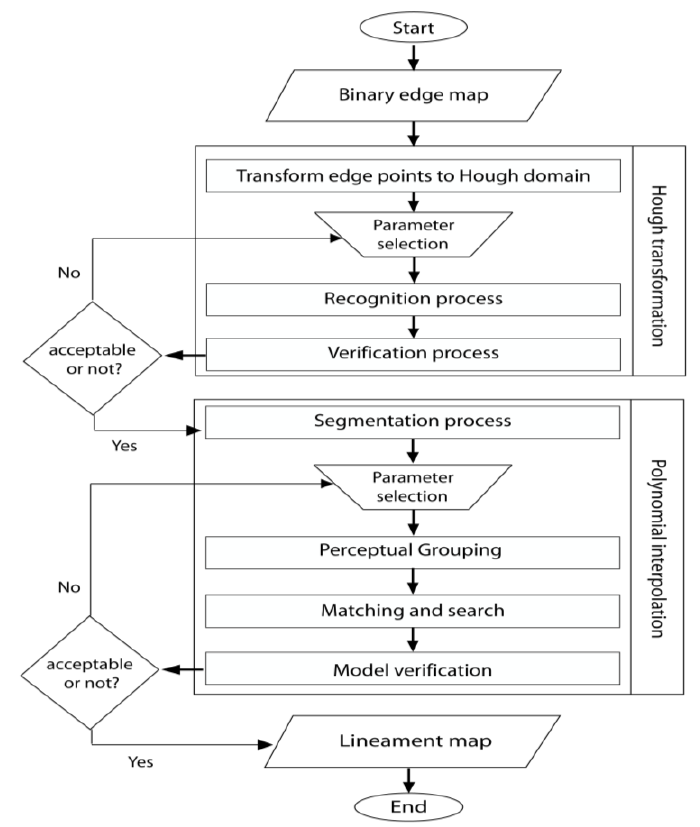
Figure 3. Overview of the essential components of linear image discontinuities extraction and grouping using TecLines.